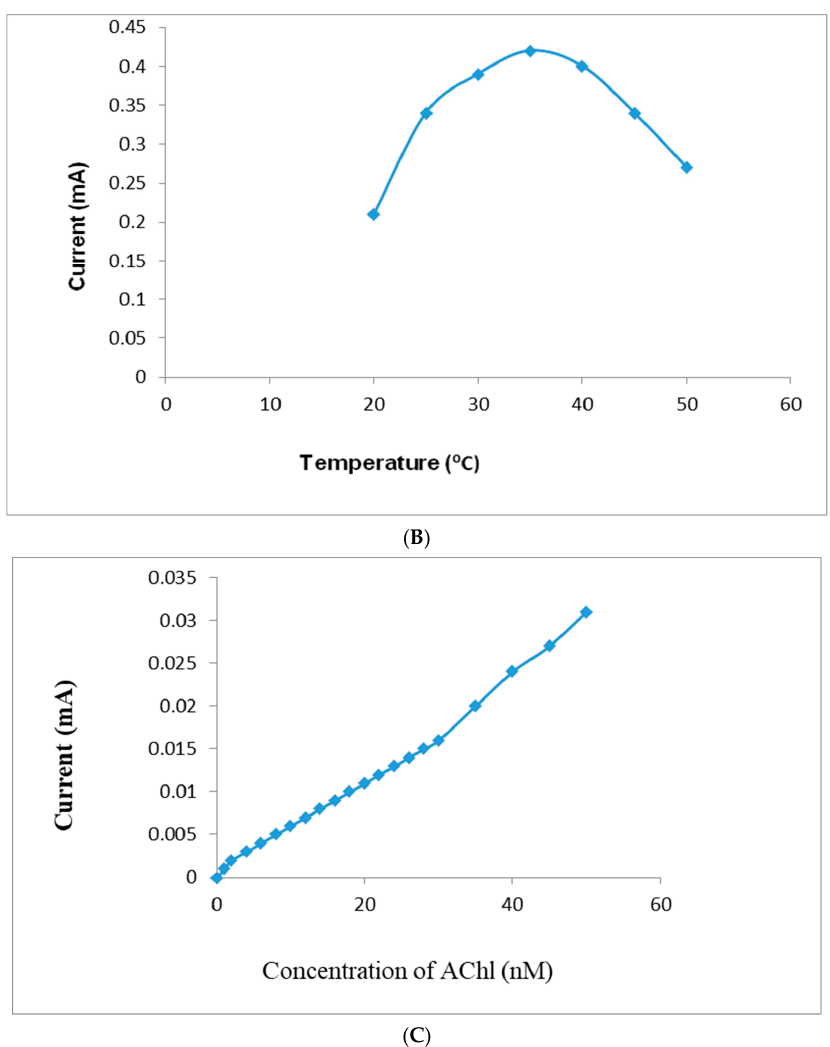
Figure 7. ( A ) In fl uence of applied pH on the current response of AChENPs/ChONPs/GONS/PtNPs/PGE. Standard conditions of assay were used, except for the pH, which was varied as given above. ( B ) In fl uence of applied incubation temperature on the current response of AChENPs/ChONPs/GONS/PtNPs/PGE. Standard conditions of assay were used, except for the incubation temperature, which was varied. ( C ) Standard curve of acetylcholine concentration by acetylcholine biosensor based on AChENPs/ChONPs/GONS/PtNPs/PGE. Standard conditions of assay were used, except for the acetylcholine biosensor, which was varied as given above. (AChENPs = Acetylcholine esterase nanoparticles; ChONPs = Choline oxide nanoparticles; GONS = Graphene oxide nanosheets; PtNPs = Platinum nanoparticles; PGE = Pencil graphite electrode).